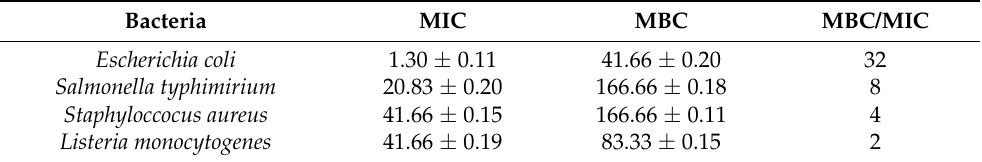
Table 3. Determination of minimum inhibitory concentration and minimum bactericidal concentra- tion exhibited by Origanum compactum ethanolic extract against bacterial strains (mg/mL). Bacteria MIC MBC MBC/MIC Escherichia coli 1.30 ± 0.11 41.66 ± 0.20 32 Salmonella typhimirium 20.83 ± 0.20 166.66 ± 0.18 8 Staphyloccocus aureus 41.66 ± 0.15 166.66 ± 0.11 4 Listeria monocytogenes 41.66 ± 0.19 83.33 ± 0.15